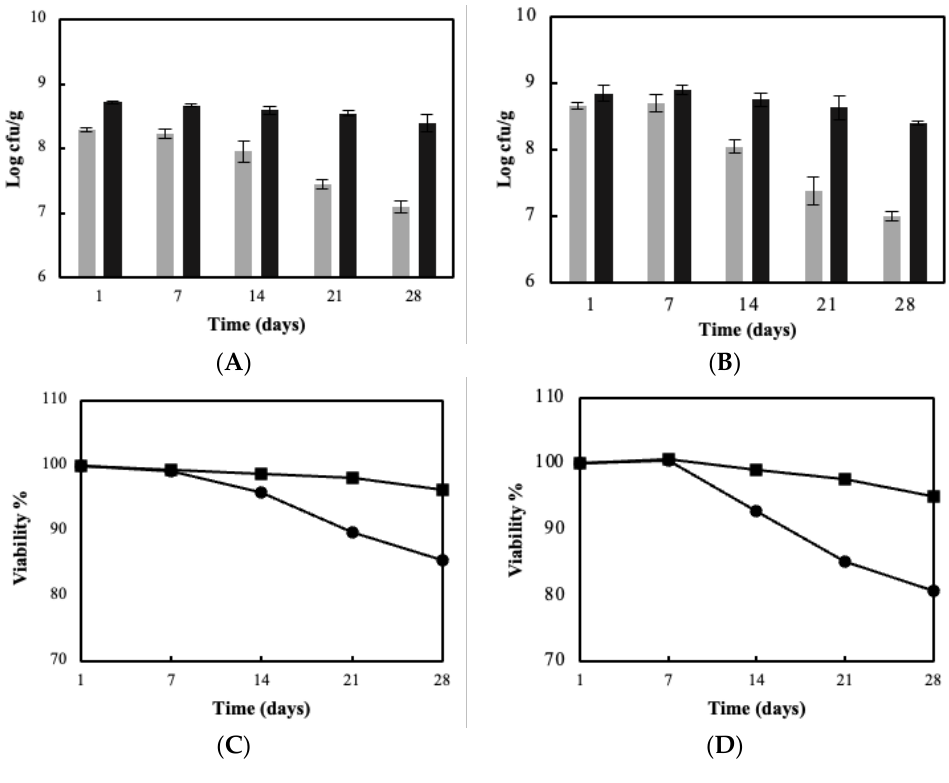
Figure 4. Milk acidification profile using free ( ● ) and immobilized biocatalysts on blended BC ( ■ ) of the strains L. pentosus B329 ( A ) and L. plantarum 820 ( B ).